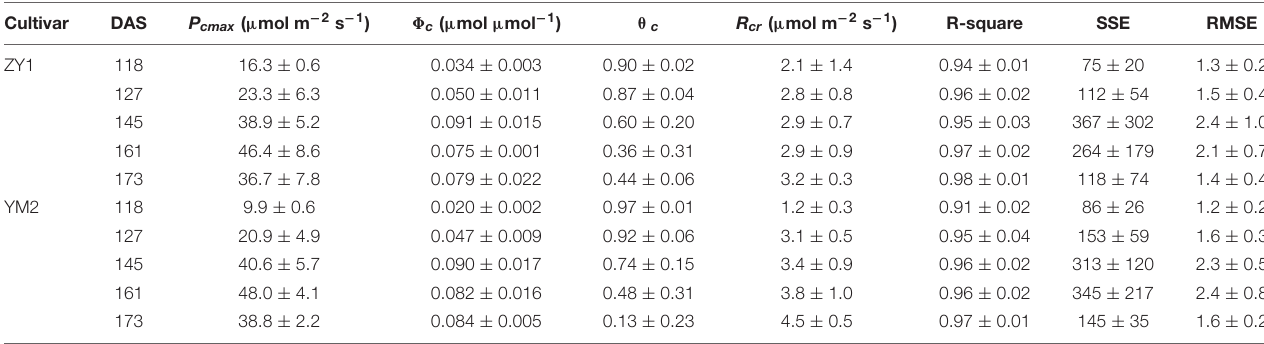
FIGURE 4 | The response of whole plant CO 2 flux (A cr ) vs. photosynthetically active radiation (PAR) per ground area at early grain filling stage for field-grown wheat (A,D) . The comparison between predicted vs. measured A cr (B,E) . The predicted (black curves) and measured (scatter points) diurnal changes of A cr for ZY1(B) (RMSE = 1.9 µ mol m − 2 s − 1 ) and YM2 (E) (RMSE = 2.62 µ mol m − 2 s − 1 ). The predicted A cr was based on recorded incident PAR and the parameters from the A cr -Q curve reconstructed with A cr data and incident PAR on the 161st day after sowing (DAS). The predicted and measured A cr were plotted against each other for ZY1 (C) and YM2 (F) . The R-square of linear regression is 0.98 for both ZY1 and YM2. TABLE 1 | Parameters derived from A cr -Q curves, which were constructed from parallel measurements of whole-plant carbon dioxide (CO 2 ) flux and of incident photosynthetically active radiation